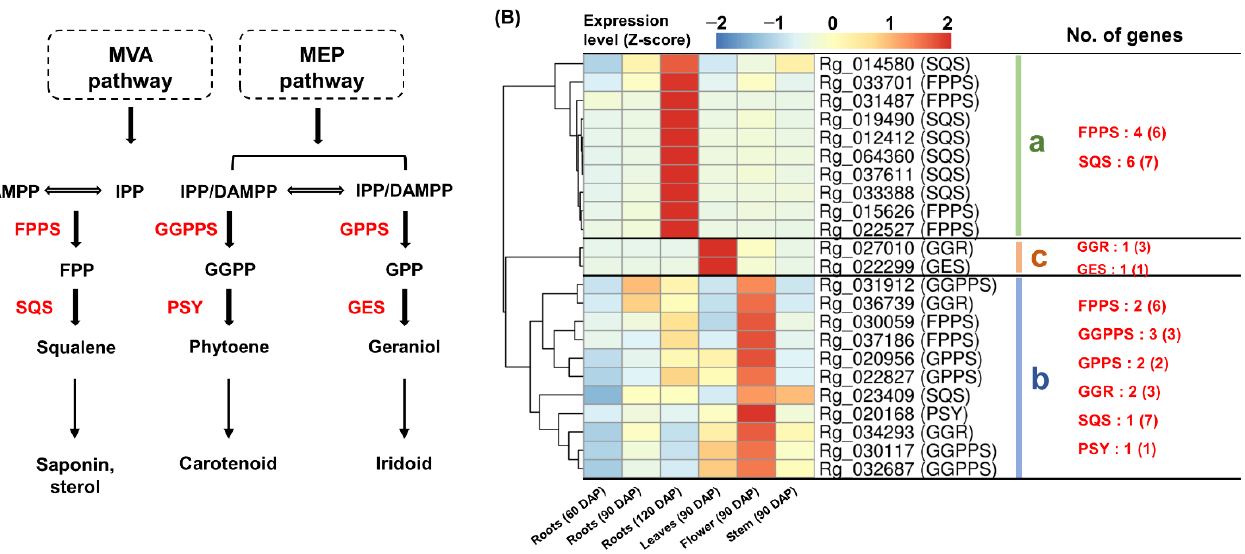
Figure 4. Expression analysis of TPS encoding genes. ( A ) The process of squalene, phytoene, and geraniol formation in the terpenoid metabolism. ( B ) Heatmap analysis of TPS encoding genes. ( a ) Genes cluster showing a strong expression in the 120 DAP roots. ( b ) Genes cluster showing a high expression in the 90 DAP flowers. ( c ) Genes cluster showing a specific expression in the 90 DAP leaves. Genes highlighted in red indicate genes assigned to each cluster and the number in parentheses is the total number of genes encoding the enzyme expressed in R. glutinosa transcriptome. TPS, terpene synthase.